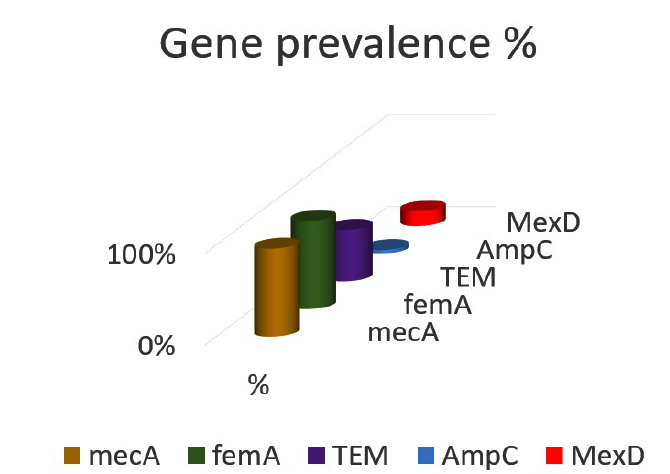
Fig. 4. A column chart represents the percentage of the presence of the resistance genes in all tested bacterial